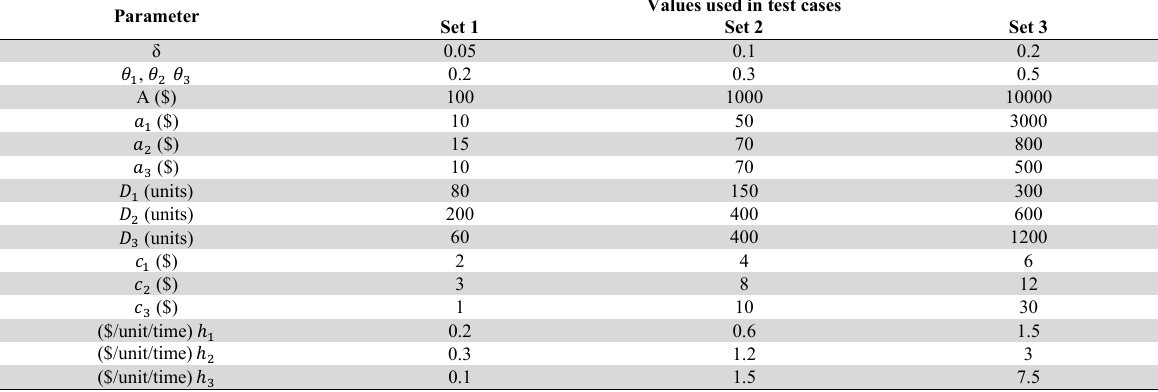
Values of the parameters used to construct the test cases Parameter